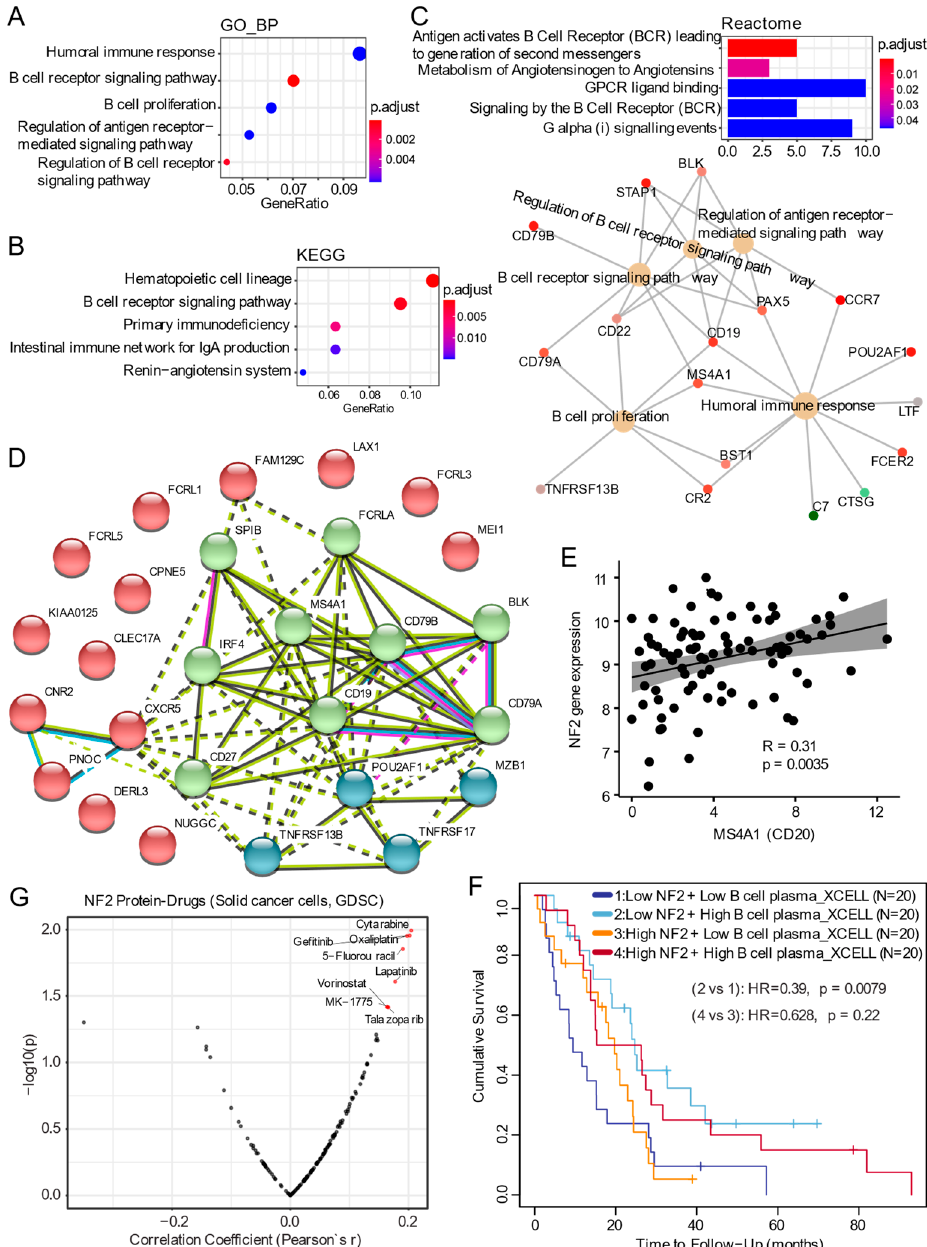
Figure 2. NF2 loss-of-function is characterized by a deficient B-cell receptor (BCR) signaling pathway. ( A – C ) The top 5 significantly enriched Gene Ontology (GO; biological process (BP)), Kyoto Encyclopedia of Genes and Genomes (KEGG) ( B ), and Reactome ( C ) pathways based on genes in the MEpink module. Cnetplot in ( C , lower panel) list genes in the enriched Reactome pathways. ( D ) STRING (https://string-db.org/ accessed on 21 December 2020) protein interaction map based on the top 30 hub genes in the MEpink module. ( E ) Correlation (Pearson r) between gene expression of CD20 (also known as MS4A1), a B-lymphocyte-specific membrane protein, and NF2 across TCGA MPM cohort. ( F ) Kaplan–Meier curves for MPM patients grouped by the plasma B-cell infiltrative signature and NF2 gene expression. The high vs. low groups are based on the median value of the indicated gene expression. Here, multiple covariates, e.g., tumor stage and purity, patients’ age and gender were included for adjustment. ( G ) Volcano plot showing the correlation between the AUC (Area the Under Curve) value of drugs and the NF2 protein level. Blue dots indicate the significantly ( p -value < 0.05) negatively correlated drugs while the red indicates the positively correlated ones. Here, a positive correlation indicates the association of a larger (more resistant) AUC value with higher gene expression and vice versa.